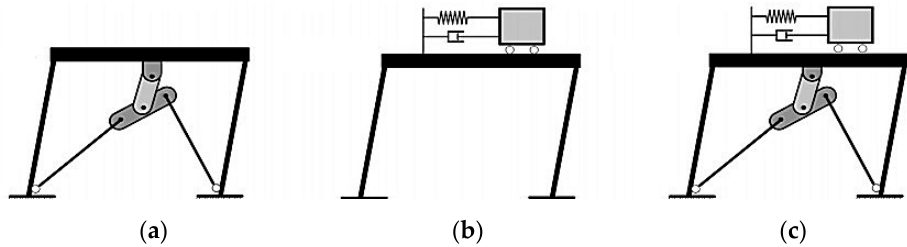
Figure 3. Three types of damping systems in the offshore jacket platforms [18]. ( a ) FDD, ( b ) TMD, ( c ) HDS.